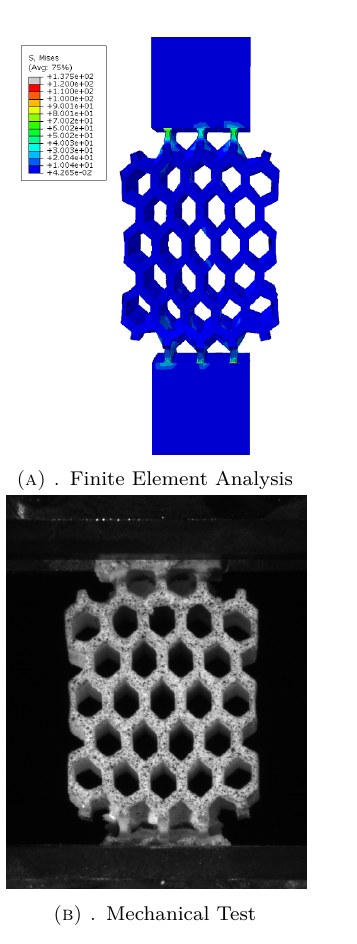
Figure 8. Tension Test of Hexagonal 5 × 5 × 3